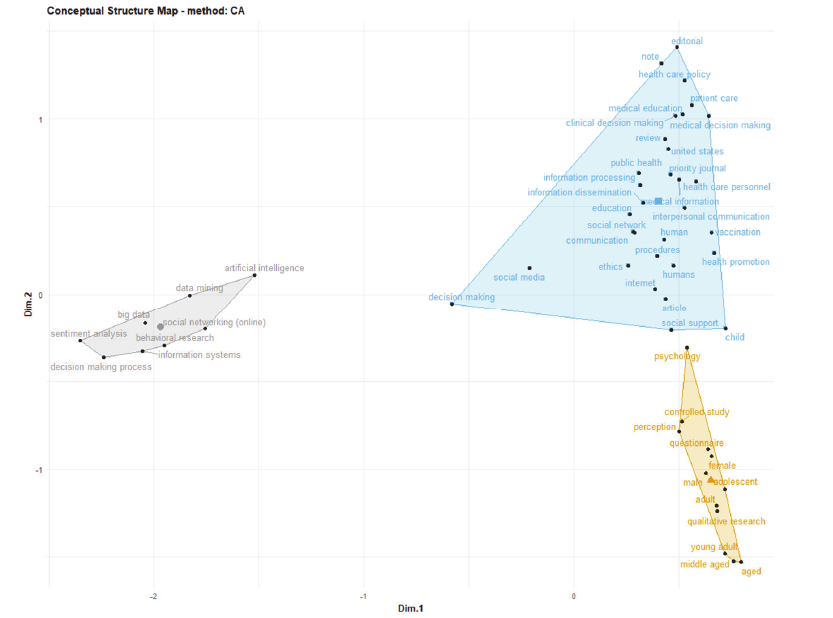
Fig. 11. Conceptual structure map with CA method